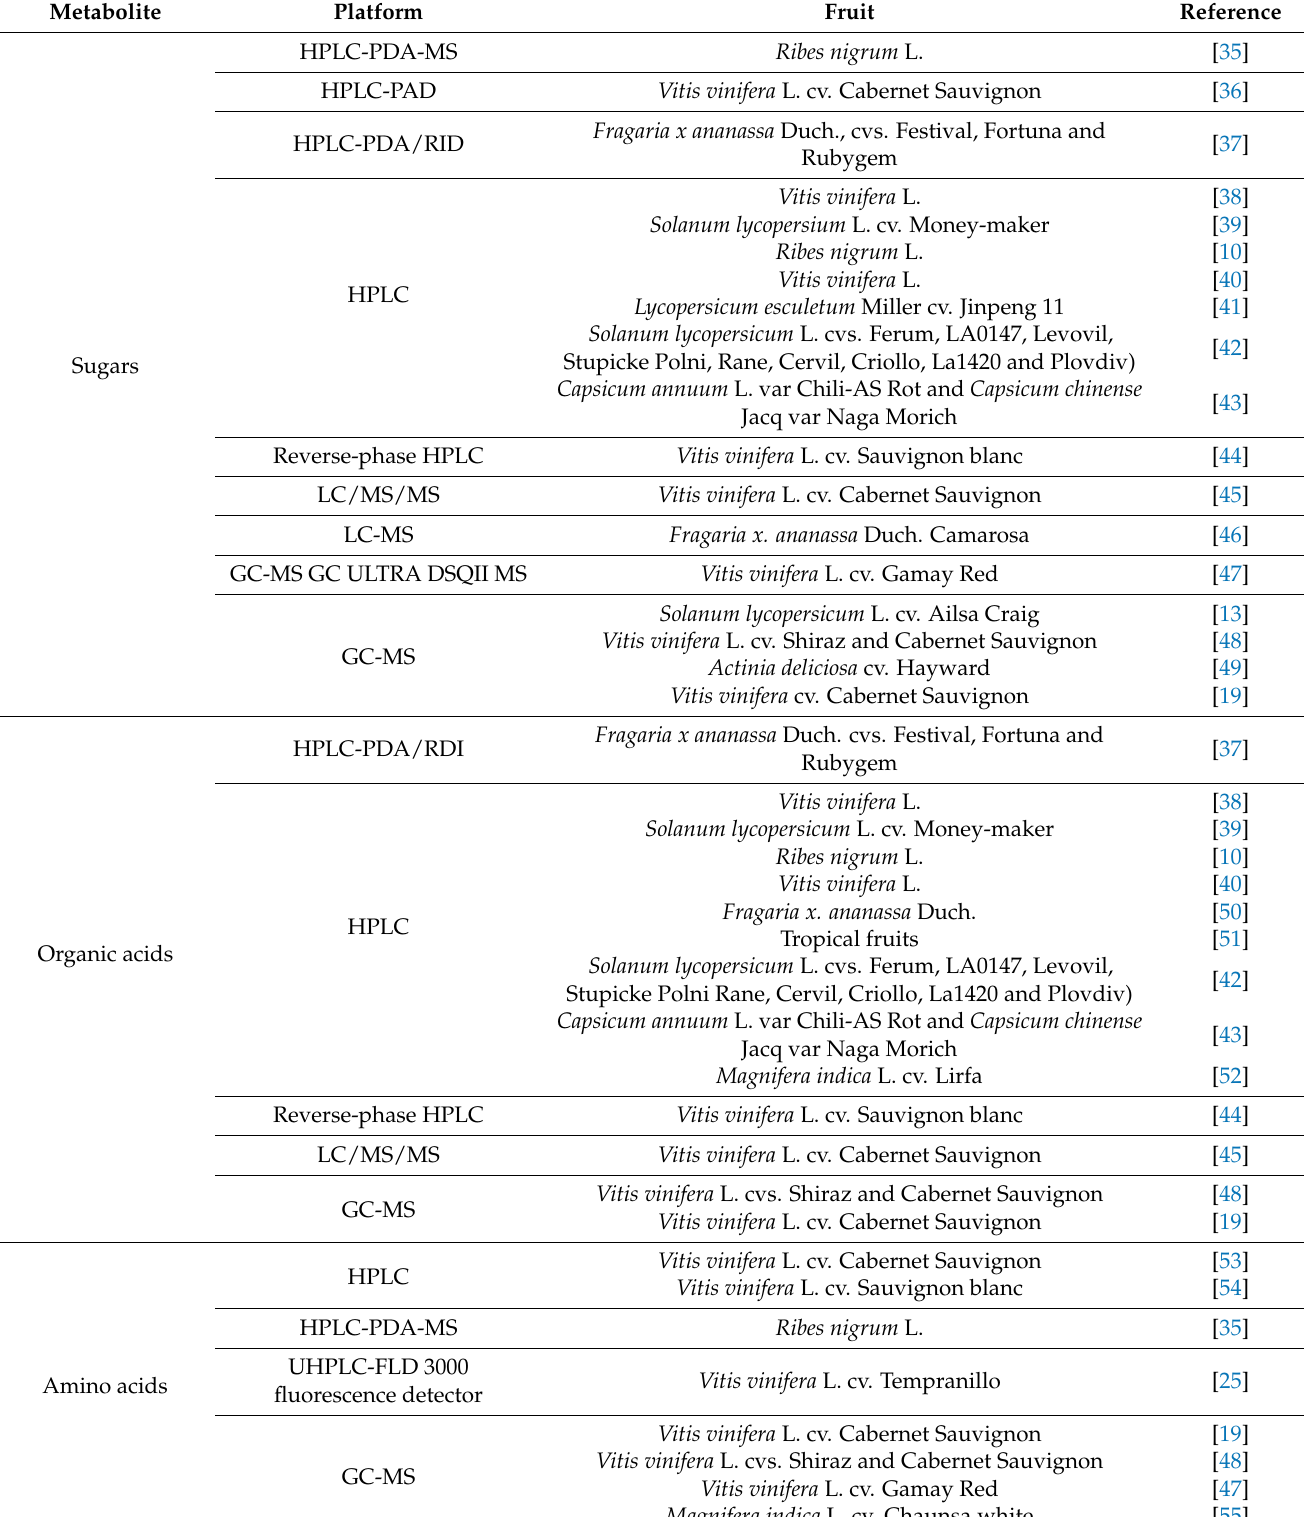
Table 1. Metabolomic platforms used in different metabolite